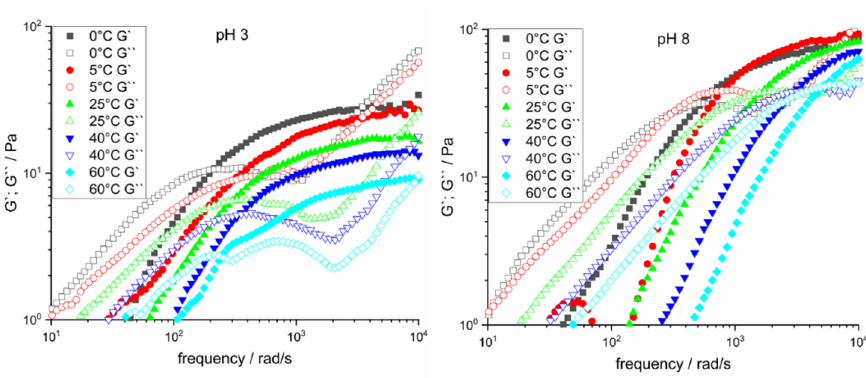
Figure 4. Evolution of the frequency response of G ′ (filled), G ″ (open symbols) for 40% concentration ( w / w %) Sophorolipid (SL) in water at different temperatures at left) pH 3 right) pH 8. Table 2. Summary of the parameters obtained from (micro-)rheology measurements for 40% SL concentration at different temperatures at pH 3 and pH 8.